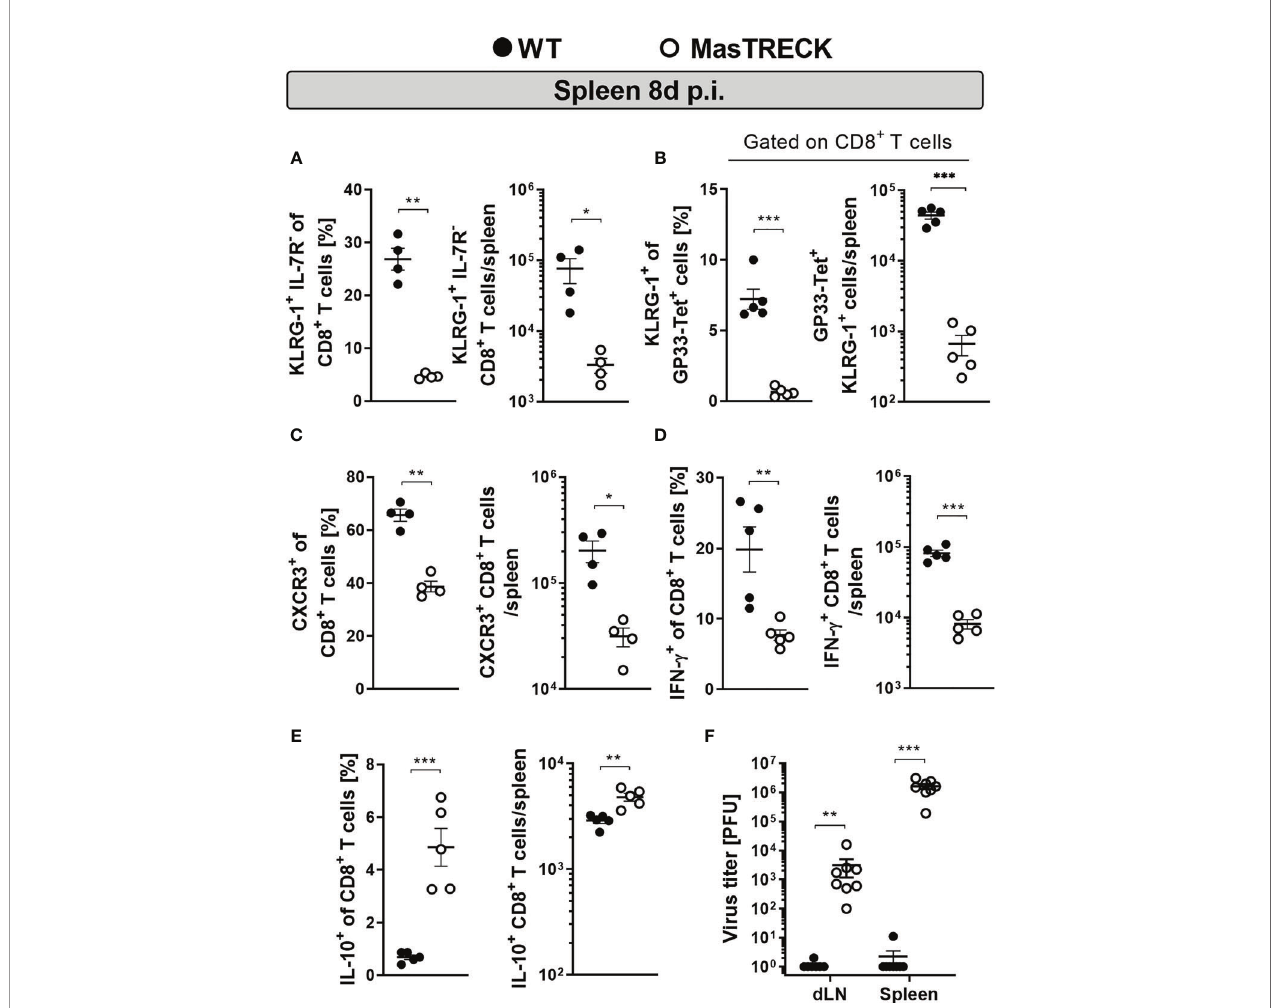
FIGURE 3 | Mast cell de fi cient mice show impaired CD8 + T cell effector phenotype and antiviral cytokine production after infection. Frequencies and absolute numbers of (A) KLRG1 + IL-7R - , (B) KLRG1 + gated on GP33-Tet + CD8 + T cells and (C) CXCR3 + CD8 + T cells in the spleen of WT and MasTRECK mice at day 8 post intradermal LCMV infection. Frequency and absolute number of (D) IFN- g – and (E) IL-10 – producing CD8 + T cells in the spleen after ex vivo restimulation with GP33 and NP396 peptides of WT and MasTRECK mice at day 8 post LCMV infection analyzed by fl ow cytometry. (F) Virus titers in ear-dLNs and spleen of WT and MasTRECK mice assessed by plaque assay at day 8 post intradermal LCMV infection. All experiments were performed at least twice, and each experimental group included n ≥ 4. Data are representative and expressed as mean ± SEM. Statistically signi fi cant differences are analyzed by t- test and indicated as follows: *p < 0.05, **p < 0.01, ***p <